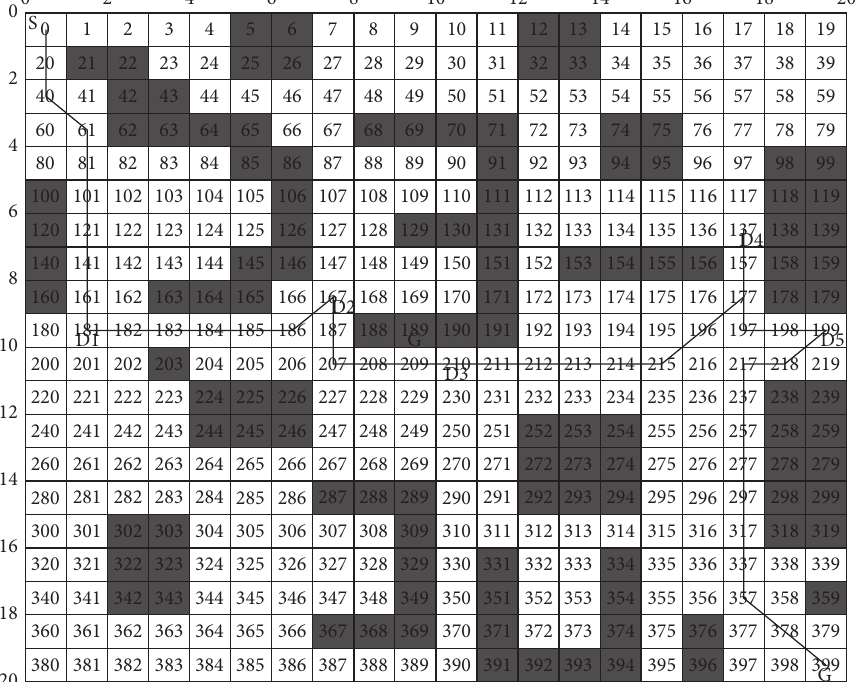
Figure 11: Ptimal path in the disordered and multiple destinations.